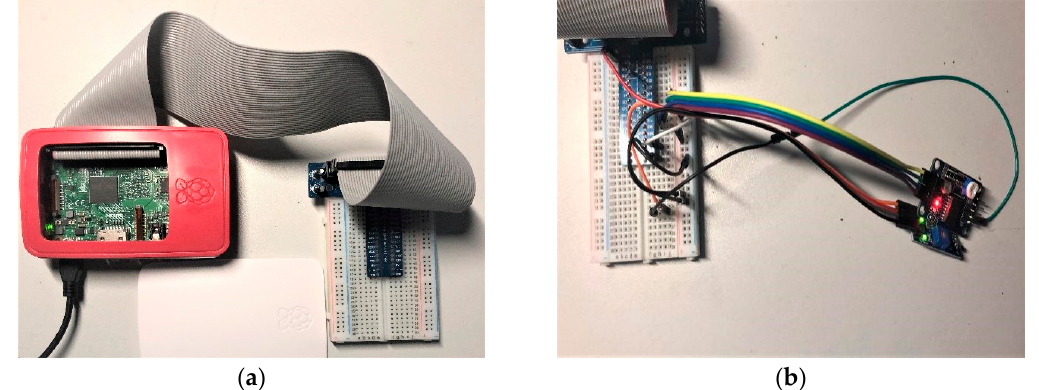
Figure 8. ( a ) Hardware device as an IoT node; and, ( b ) Breadboard with sensors installed.